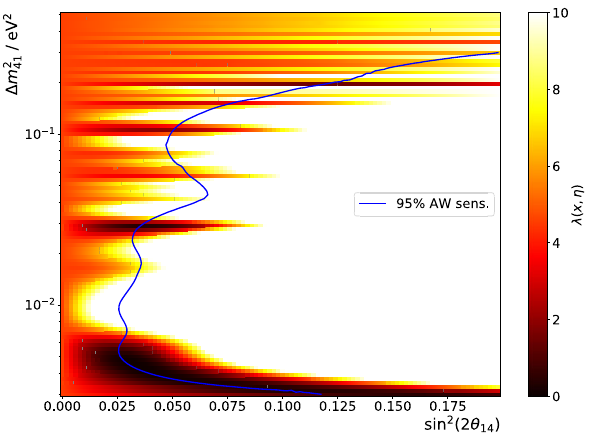
Fig. 5 Example analysis of a pseudo data set representing the null hypothesis. The data set was generated with Poissonian fluctuations from a Monte Carlo data set. The blue line represent the 95% sensitivity (as defined in the text) for constraining sin 2 2 θ 14 as a function of Δ m 2